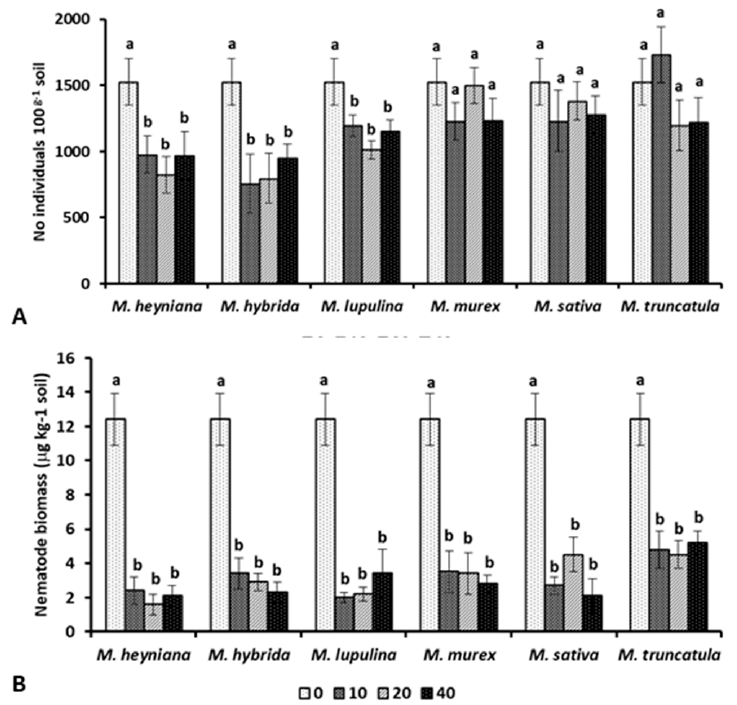
Figure 1. Total nematode abundance ( A ) and biomass ( B ) in soil amended with 10, 20, or 40 g kg − 1 soil rates of dry plant biomass of six Medicago plant species.